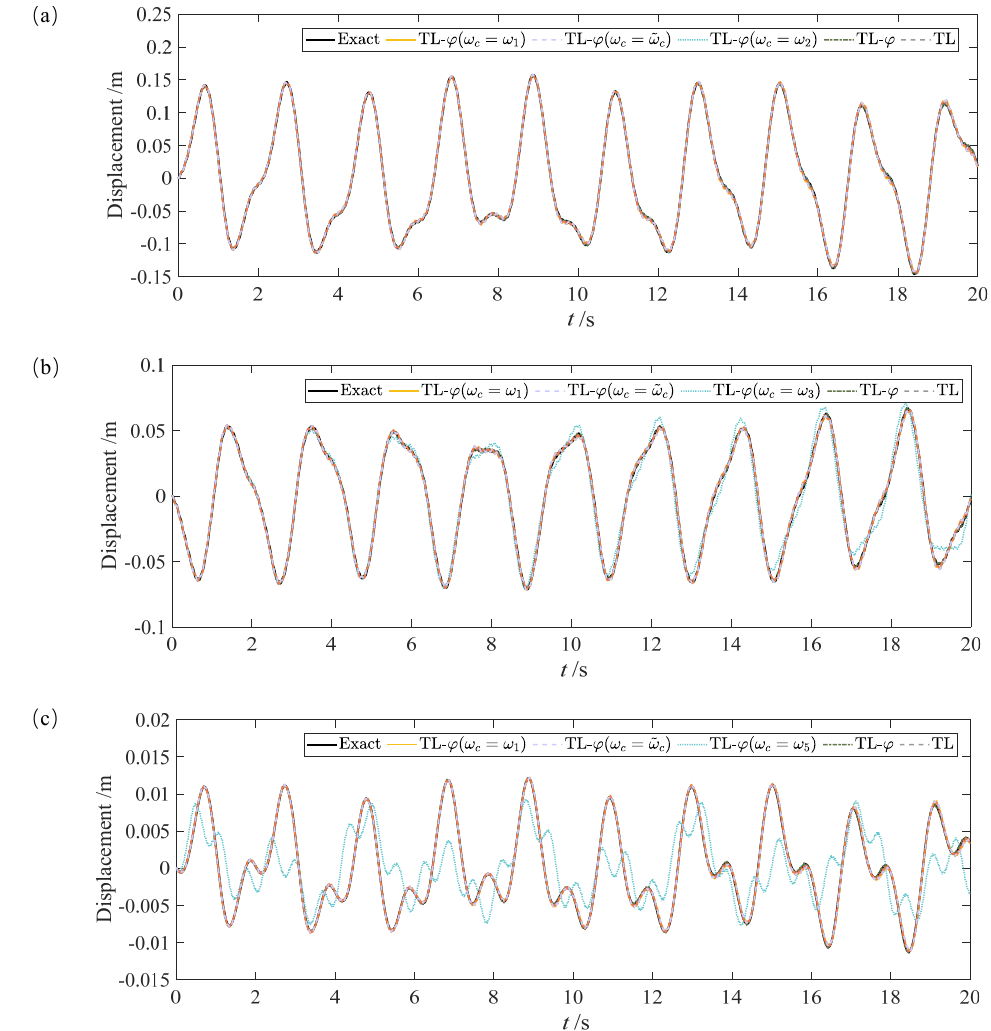
Figure 10. Displacement responses of the 5-story building (G2). ( a ) R = φ 2 . ( b ) R = φ 3 . ( c ) R = φ 5